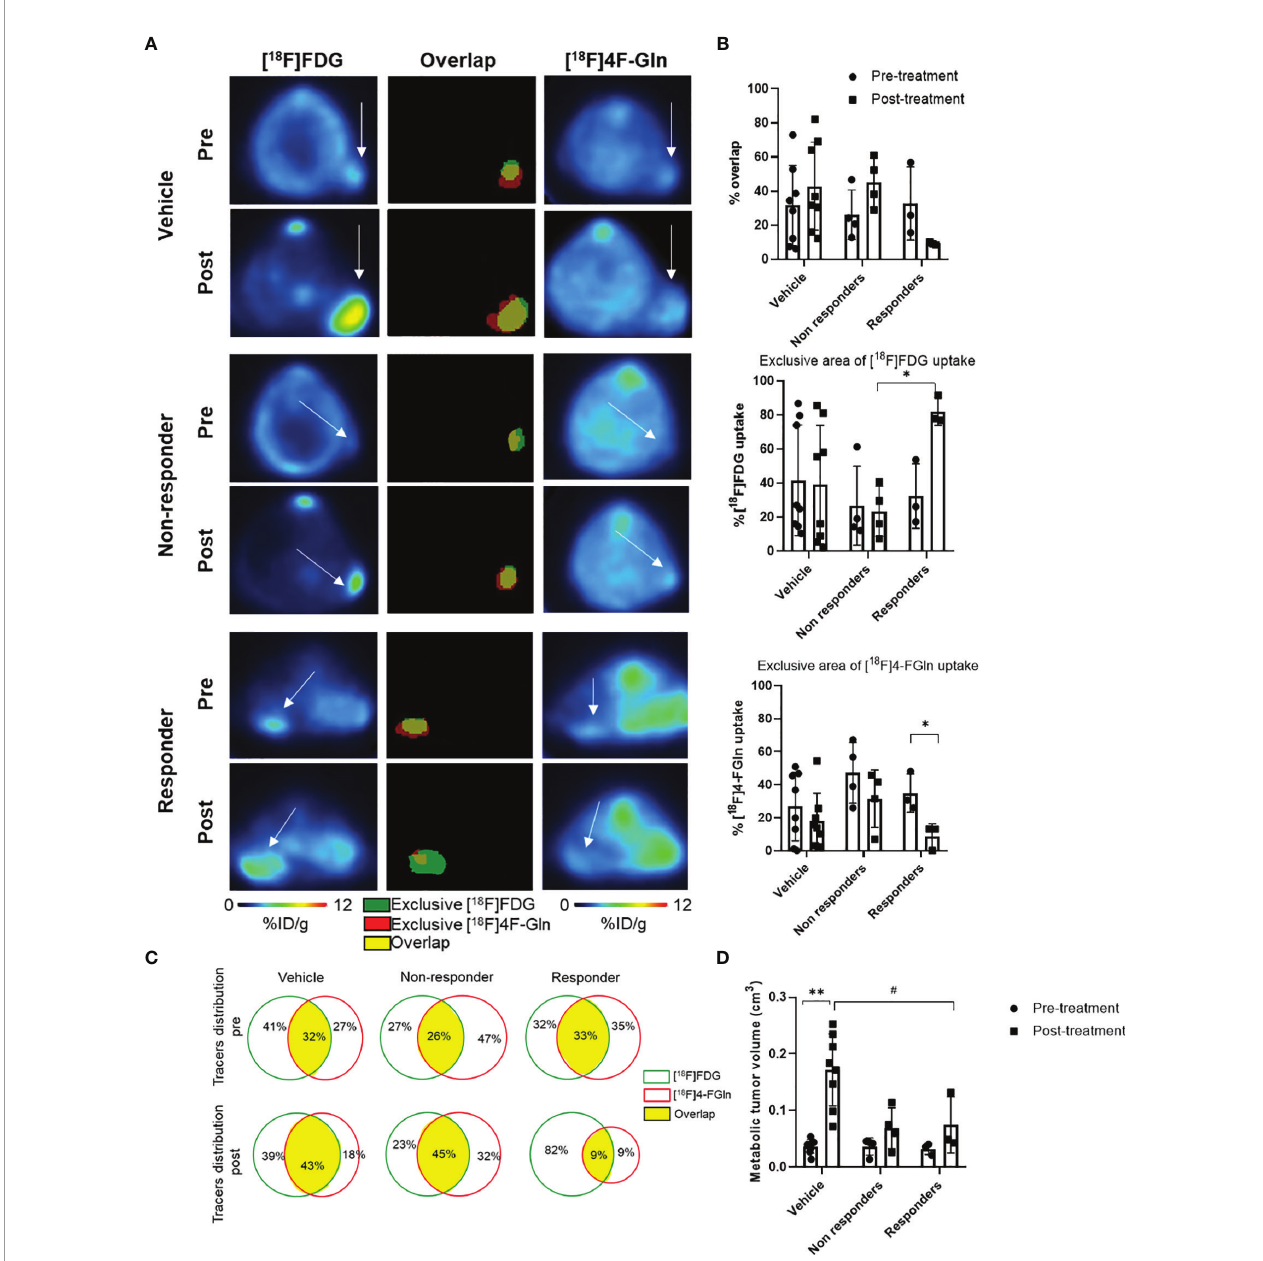
FIGURE 7 | Volumetric analysis de fi nes the distribution of tracers in the tumor and highlights speci fi c therapy-induced alterations in the uptake of individual tracers. (A) representative transaxial PET images from [ 18 F]FDG and [ 18 F]4-FGln and the overlay image of [ 18 F]FDG and [ 18 F]4-FGln masks in the same mice (vehicle, Bortezomib-non-responder and responder) pre- and post-treatment. White arrows indicate tumor. In overlay images, green color represents exclusive [ 18 F]FDG uptake, red color represents exclusive [ 18 F]4-FGln uptake, and yellow color represents co-distribution of both radiopharmaceuticals. (B) % of overlap, exclusive [ 18 F] FDG and [ 18 F]4-FGln tracer uptake volumes in vehicle- and Bortezomib-treated responder and non-responder groups. Differences intra- and intergroups were tested for signi fi cance using one-way ANOVA with multiple comparisons corrected with Tukey ’ s test and Wilcoxon matched pairs signed rank test. *p < 0.05. (C) Quantitative analysis of single tracers uptake and total distribution pre-and post-treatment in vehicle- and Bortezomib-treated non-responder and responder groups; the green lines represent [ 18 F]FDG unique area, red lines represent [ 18 F]4-FGln unique area, and the yellow fi lled space is the overlap of both tracers. (D) Metabolic tumor volume (sum of [ 18 F]FDG and [ 18 F]4-FGln volume of biodistribution) pre- and post-treatment with vehicle and Bortezomib in responders and non-responders. Differences intra- and intergroups were tested for signi fi cance using one-way ANOVA with multiple comparisons corrected with Tukey ’ s test and Wilcoxon matched pairs signed rank test. # p = 0.027; **p =